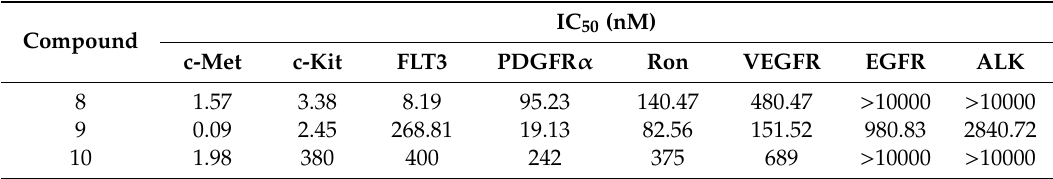
Table 3. Inhibition of tyrosine kinases by compounds 8 , 9 and